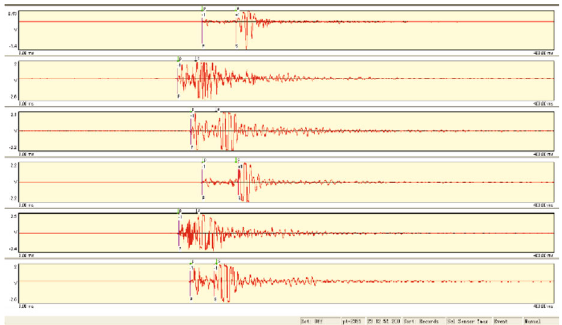
Figure 31: Slight rock burst